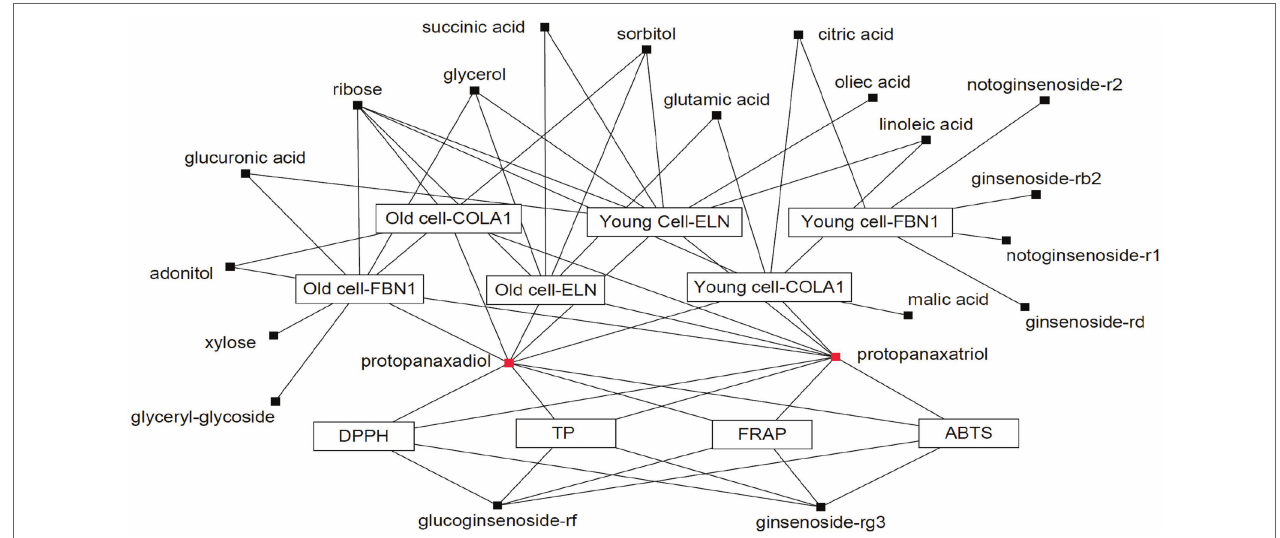
FIGURE 4 | Correlation network between metabolites and bioassays. Box: metabolites; Eclipse: